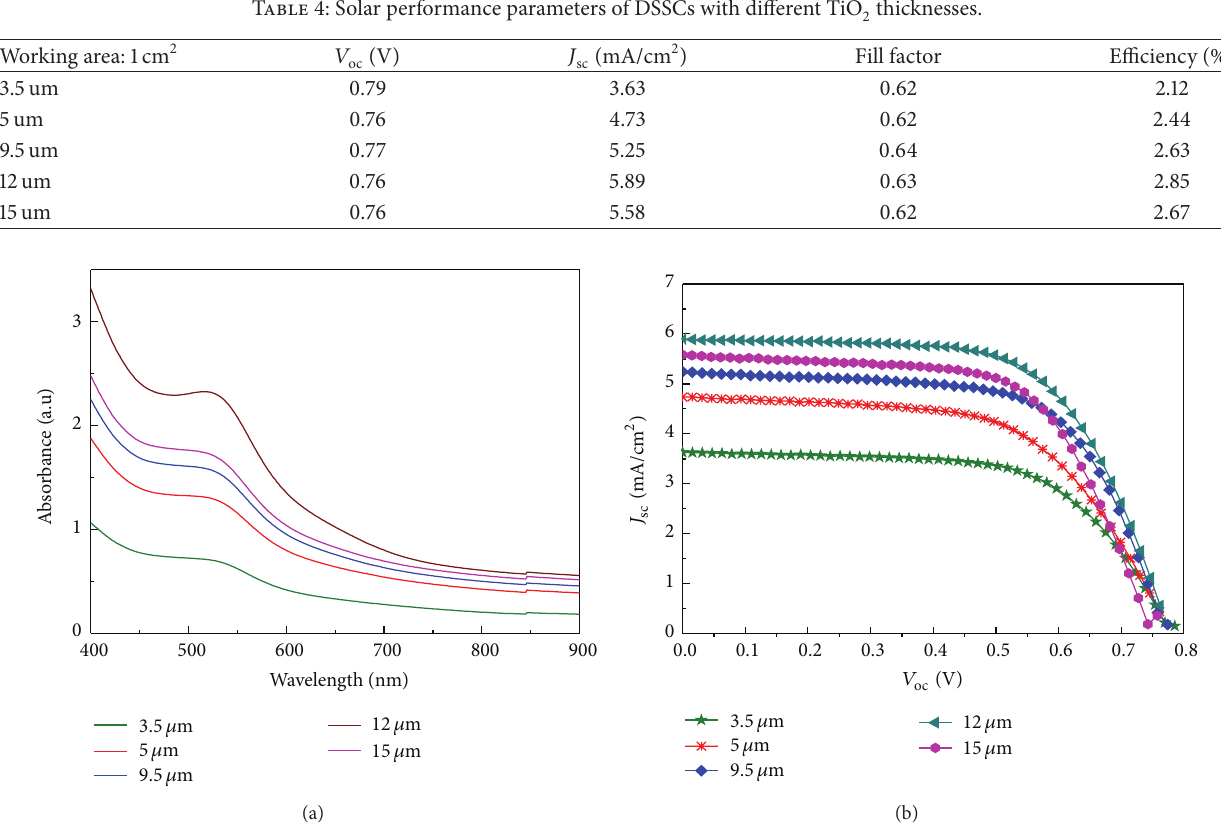
Figure 7: (a) Light absorption and (b) 𝐼 - 𝑉 curve of dye-sensitized solar cells with different TiO 2 thicknesses.